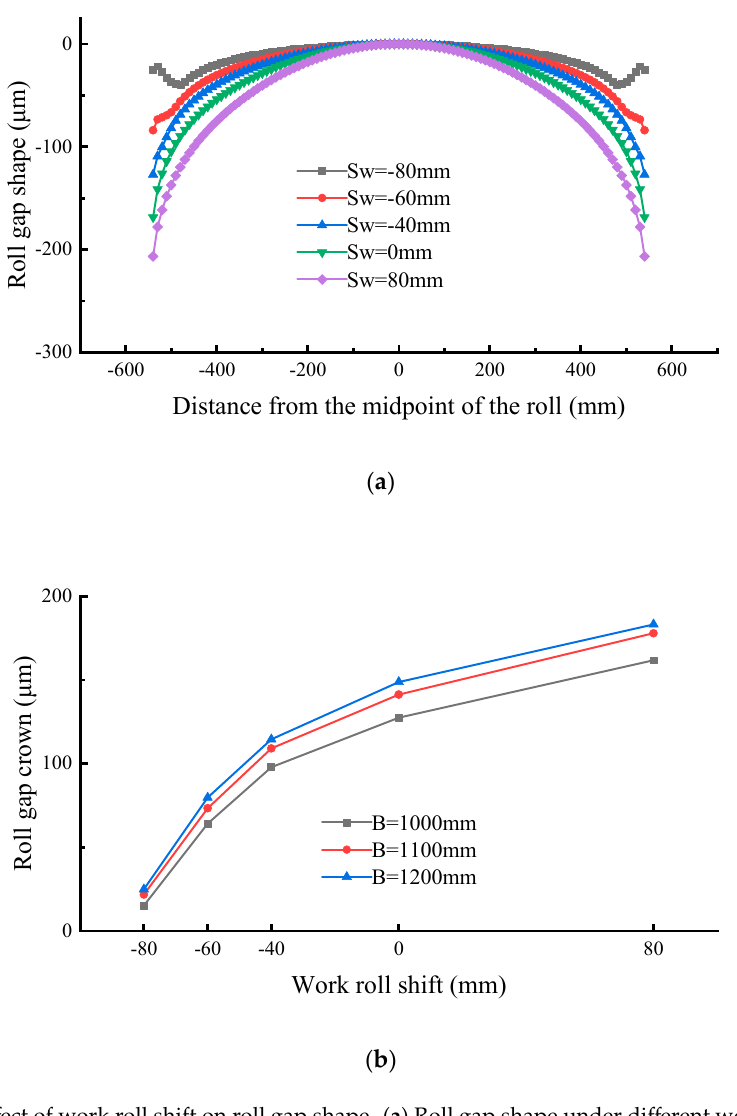
Figure 10. E ff ect of work roll shift on roll gap shape. ( a ) Roll gap shape under di ff erent work roll shifts, Figure 10. Effect of work roll shift on roll gap shape. ( a ) Roll gap shape under different work roll ( b ) e ff ect of work roll shift on roll gap shifts, ( b ) effect of work roll shift on roll gap crown.